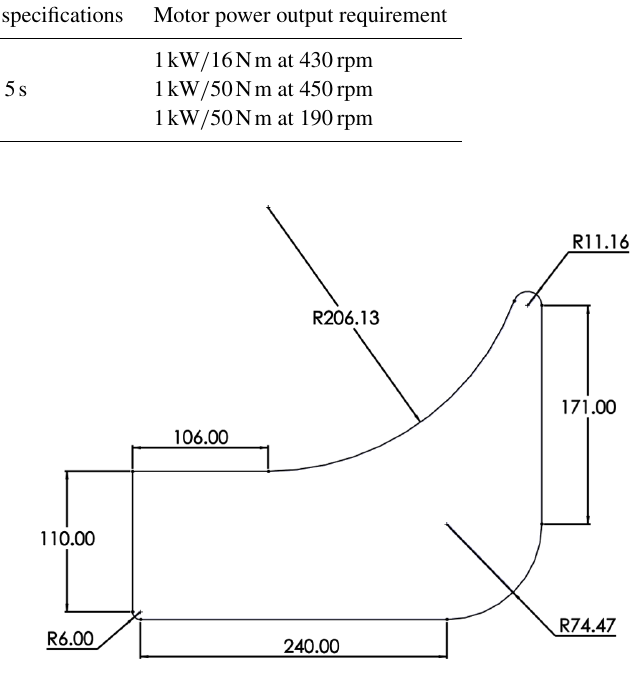
Figure 3. Schematic diagram of the simulated racing